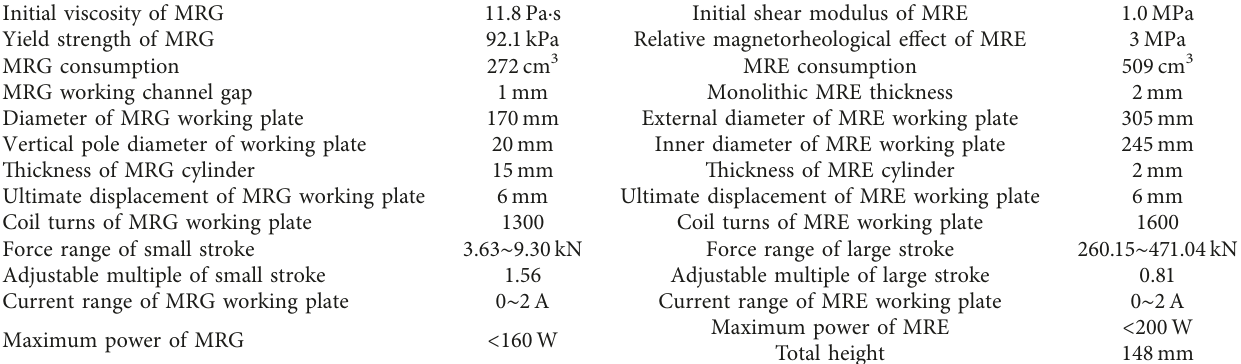
Table 3: The main design parameters of MRE smart isolator performance.